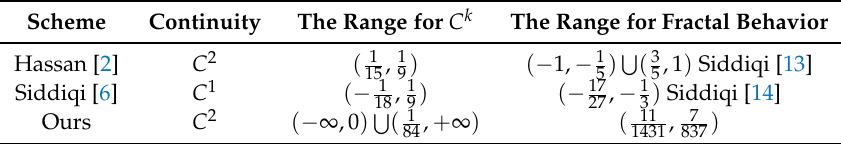
Table 1. Comparison of existing ternary 4-point interpolation subdivision schemes.